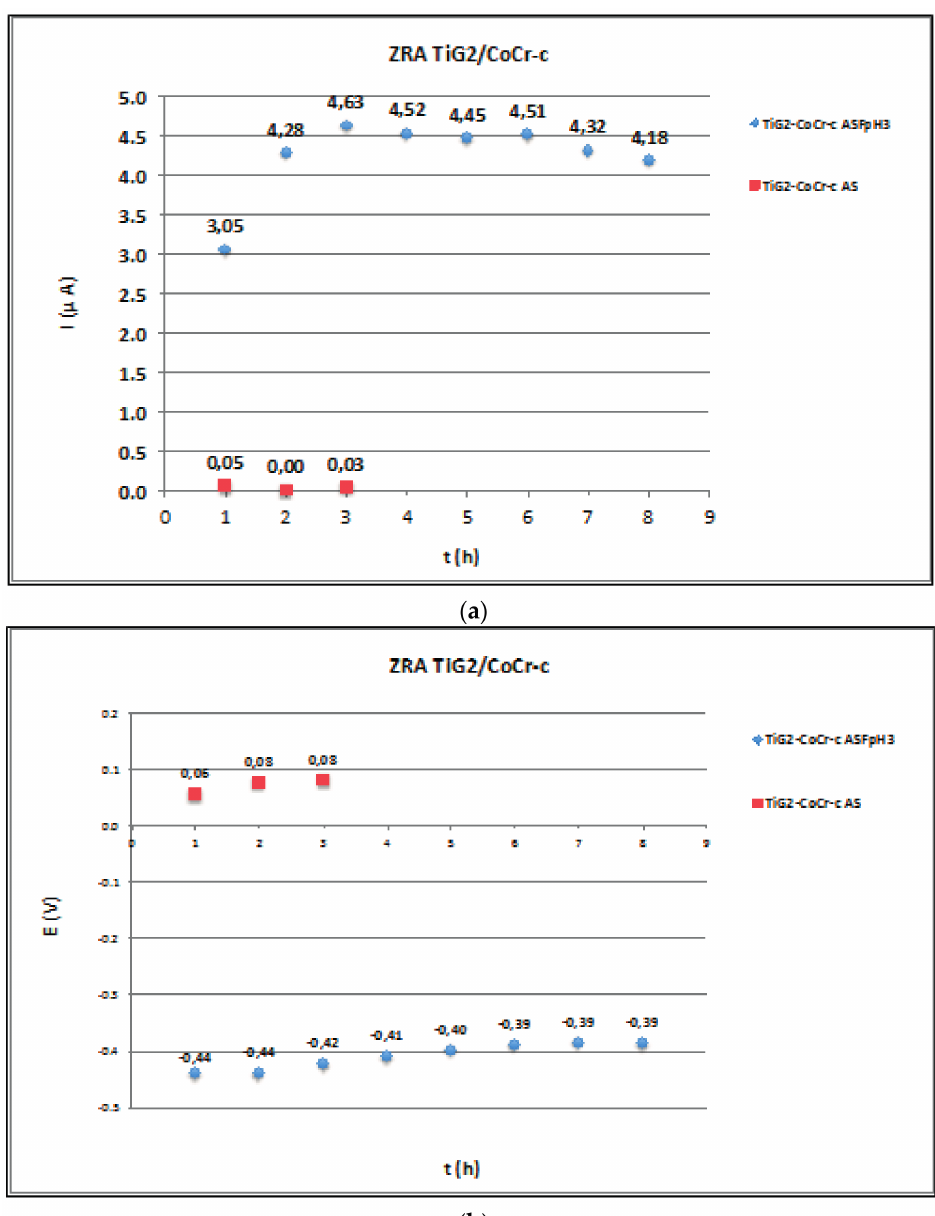
Figure 5. Average values at the end of every hour of immersion of the ( a ) galvanic current and ( b ) galvanic potential of the TiG2/CoCr-c pair in AS and ASF − pH3 as a function of time. Legend: Au: gold-palladium alloy; CoCr: cobalt-chromium alloy; CoCr-c: cobalt-chromium cast alloy; NiCrTi: nickel-chromium-titanium alloy; Ti64: Titanium-6Aluminium-4Vanadium Titanium alloy); TiG2: Titanium grade 2; rep: repetition of the